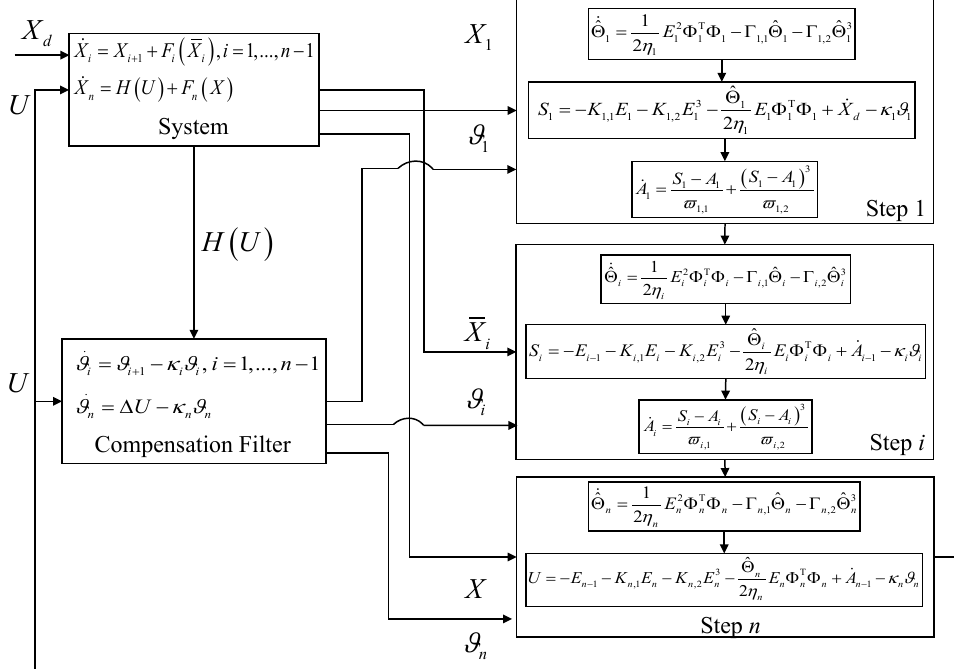
Figure 2. The flow chart of the presented